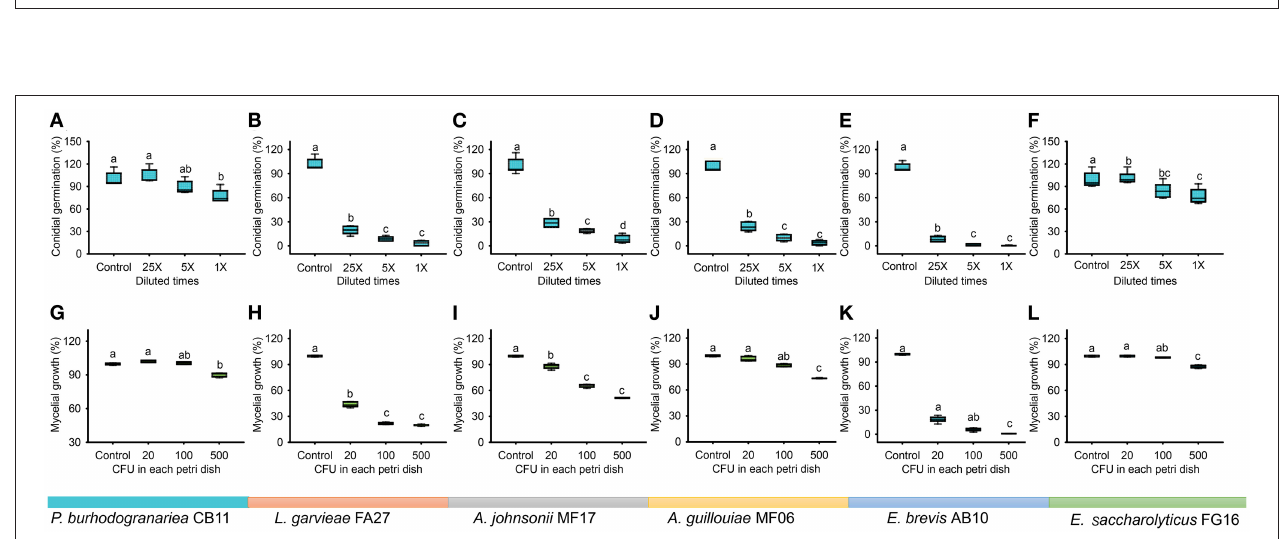
FIGURE 6 | Conidial germination and mycelial growth of B. bassiana BB1101 under the effects of dominant bacterial species associated with D. antiqua larvae. (A–F) Conidial germination of B. bassiana BB1101 under the effects of P. burhodogranariea CB11, L. garvieae FA27, A. johnsonii MF17, A. guillouiae MF06, E. brevis AB10, and E. saccharolyticus FG16, respectively. (G–L) Mycelial growth of B. bassiana BB1101 under the effects of P. burhodogranariea CB11, L. garvieae FA27, A. johnsonii MF17, A. guillouiae MF06, E. brevis AB10, and E. saccharolyticus FG16, respectively. Different letters above each box refer to significant differences within each set of boxes (one-way or Welch’s ANOVA, p < 0.05, n = 6).